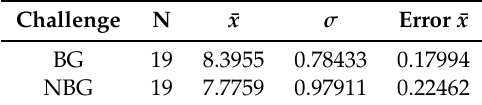
Table 13. Mean and deviation standard of the Balanced and Unbalanced challenges.